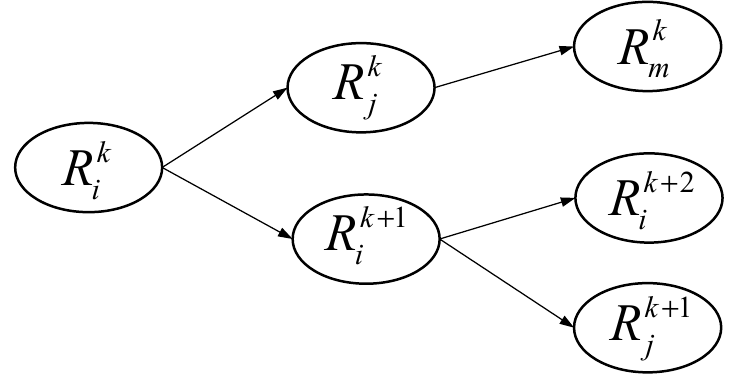
Figure 4. Indirect impact path of risk.